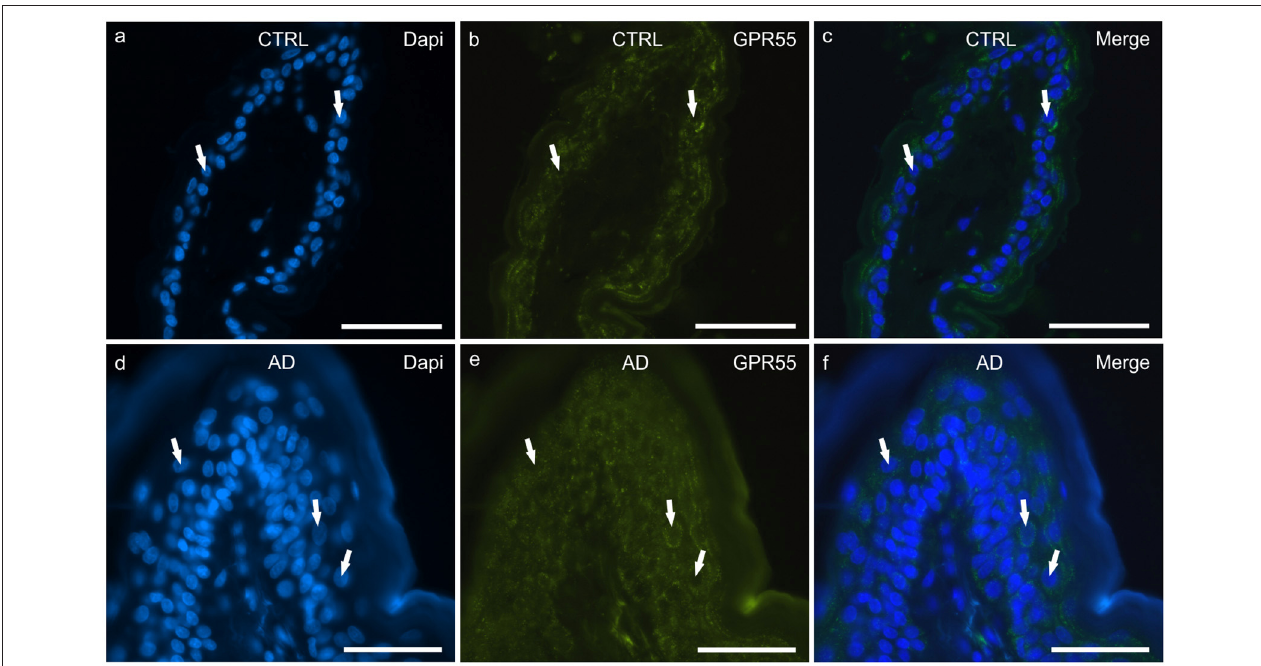
FIGURE 3 | Photomicrographs of cryosections of canine skin showing G protein-coupled receptor 55 (GPR55) immunoreactivity (IR) in the tissues of the healthy dogs (CTRL) (a–c) and in the dogs with atopic dermatitis (AD) (d–f) . (a–c) The white arrows indicate the DAPI-labeled nuclei of the keratinocytes showing moderate cytoplasmic GPR55-IR. (d–f) The white arrows indicate some DAPI-labeled nuclei of the cells of the suprabasal layer showing moderate-to-bright GPR55-IR. Bar, 50 µ